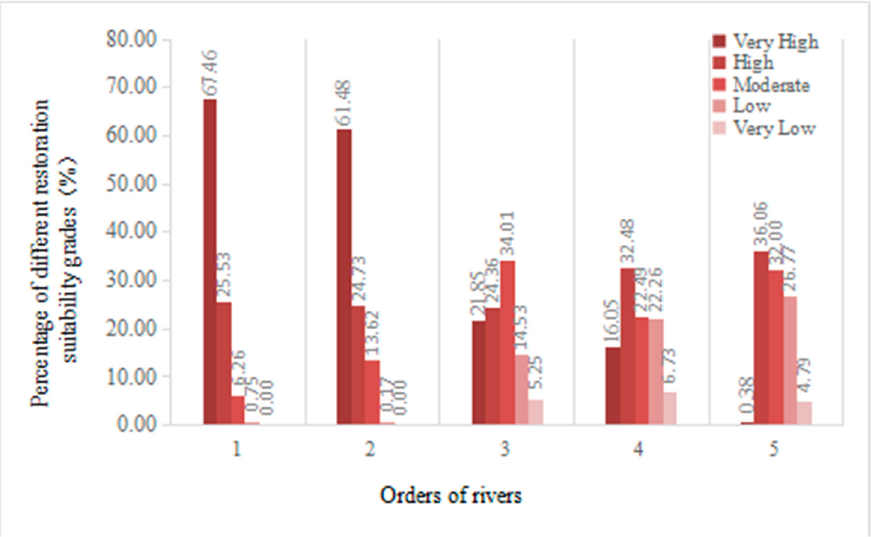
Figure 2. Percentage of different restoration suitability grades in the same buffer distance of dif- ferent river orders. river